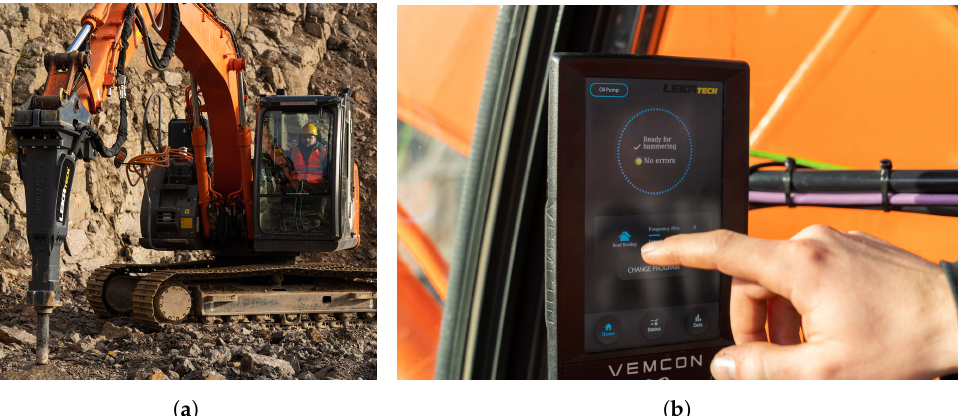
Figure 16. The Lekatech electric hammer (LEH) based on a linear electric motor installed on the excavator ( a ) and the user interface ( b ) (Lekatech [117]).